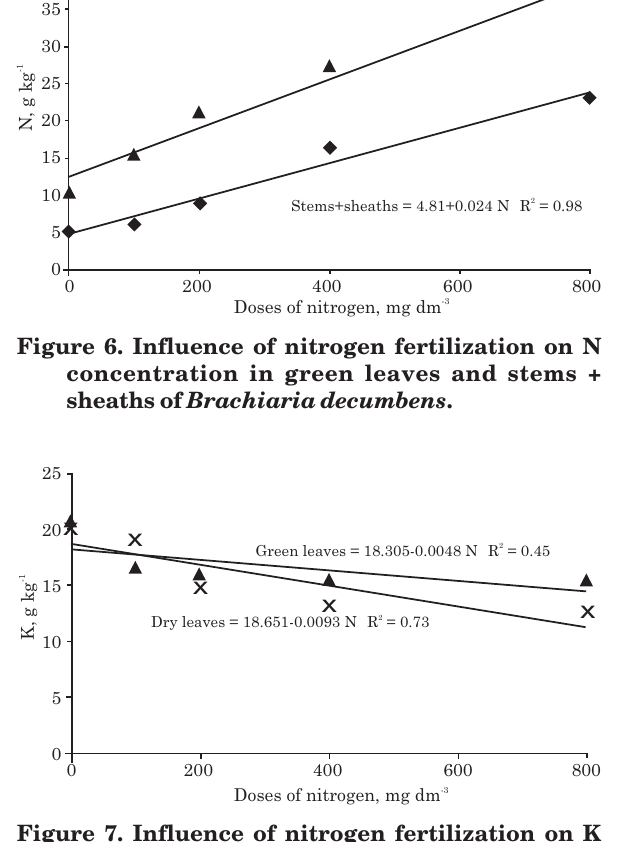
Figure 7. Influence of nitrogen fertilization on K concentration in green leaves and dry leaves of Brachiaria decumbens .